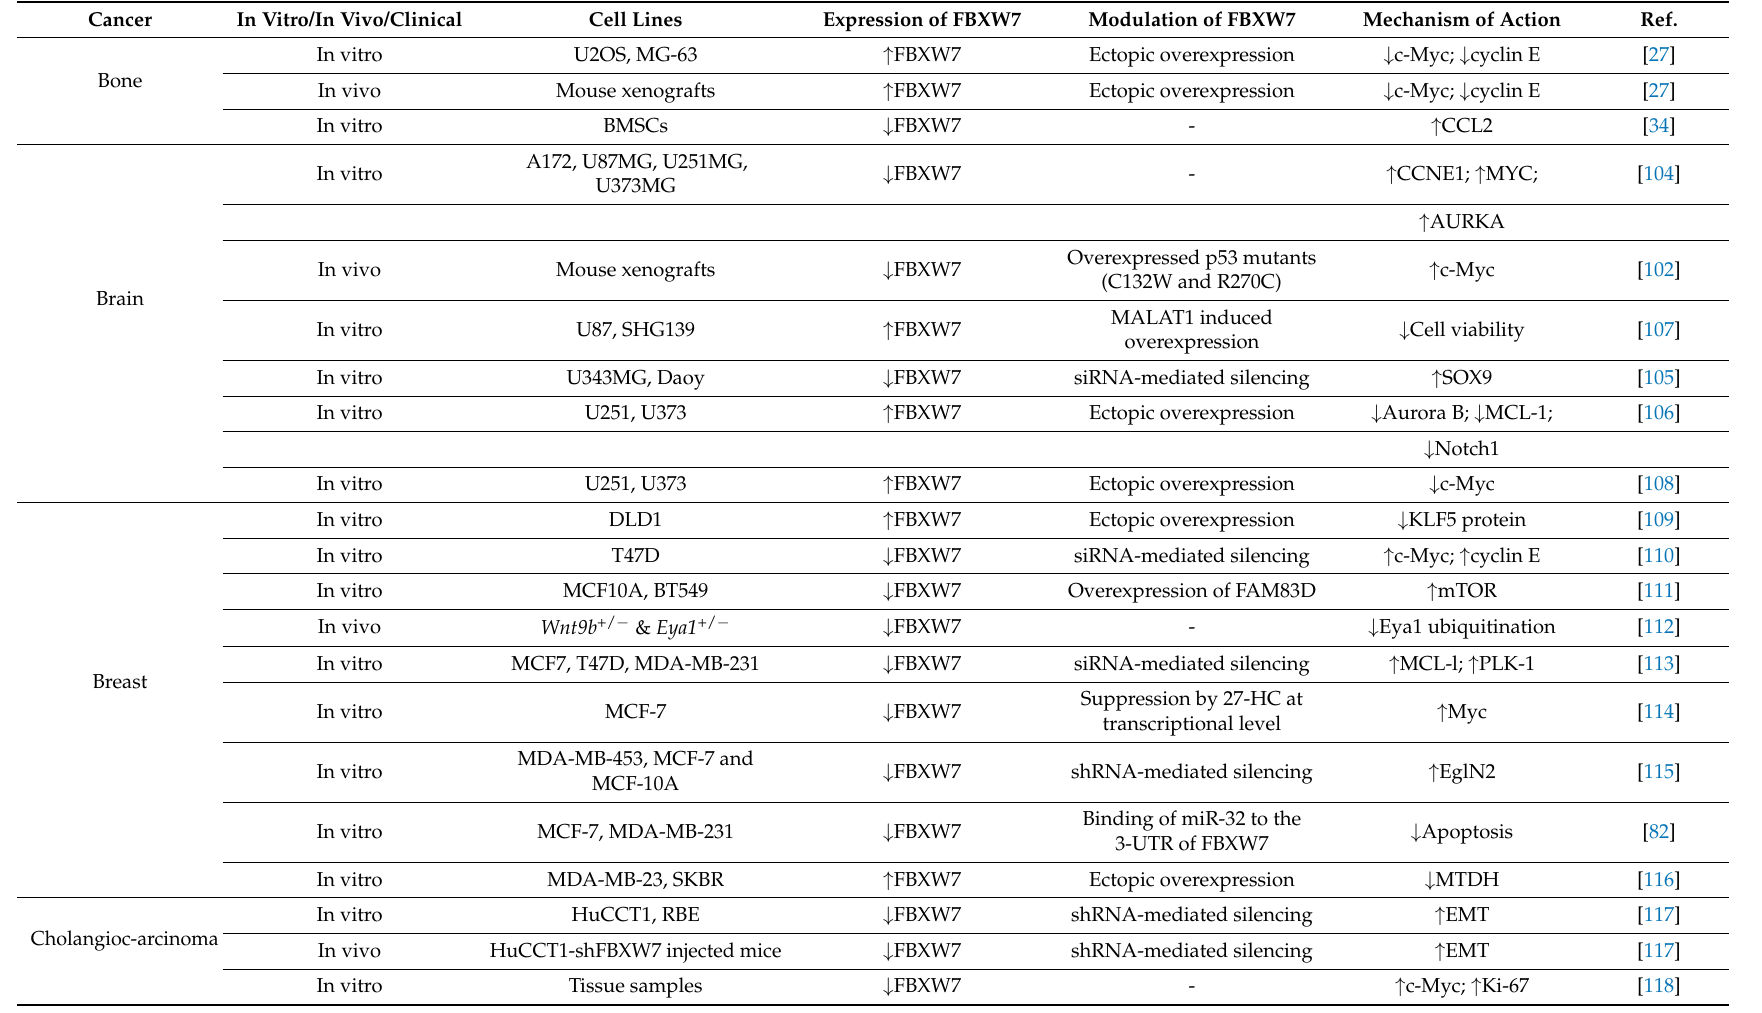
Table 1. Role of FBXW7 in few selected